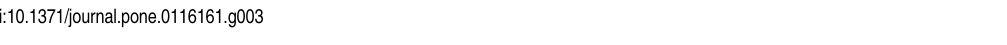
PLOS ONE | DOI:10.1371/journal.pone.0116161 December 30,